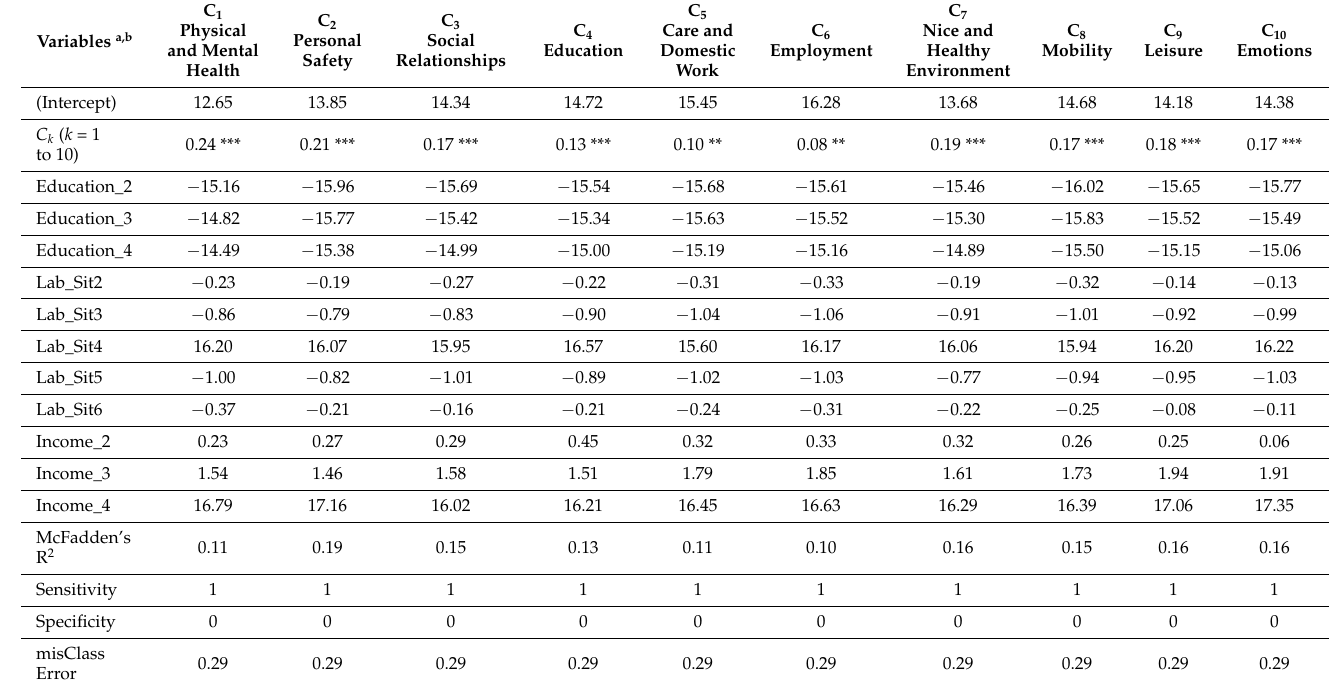
Table A3. Significance of coefficients of regressions with different capabilities. Women and age 18 to